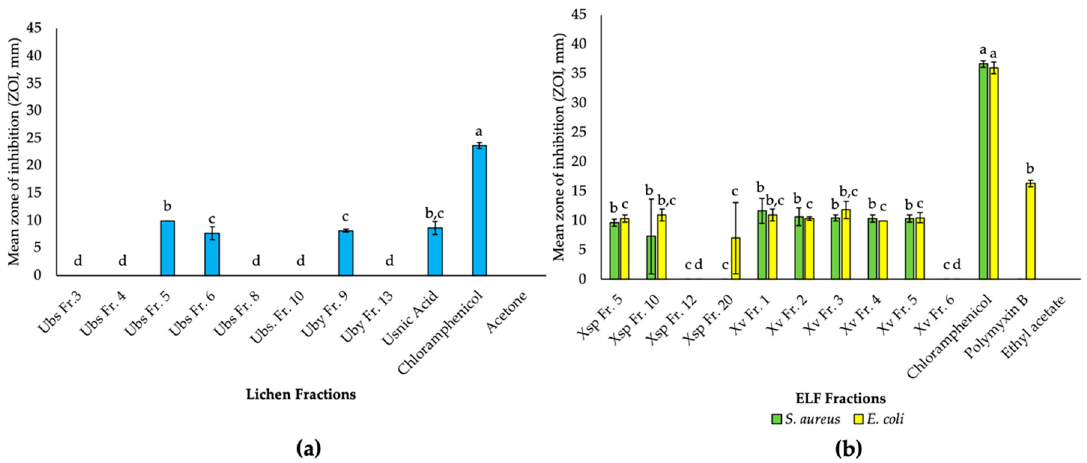
Figure 2. Biological activities of lichen and ELF fractions. ( a ) Antibacterial activities of U. bismolliuscula (PH, UbsPH) and U. baileyi (MY, UbyMY) fractions against S. aureus ATCC 25923. ( b ) Antibacterial activities of Xylaria sp. (MY, Xsp) and X. venustula (PH, Xv) fractions against S. aureus ATCC 25923 and E. coli ATCC 25922. Standard deviation values are indicated by the error bars ( p < 0.05). Letters above error bars indicate the statistical significance within groups using one-way ANOVA and Tukey HSD. a, b, c, d different letters indicated on the columns denote statistical significance between respective fractions.